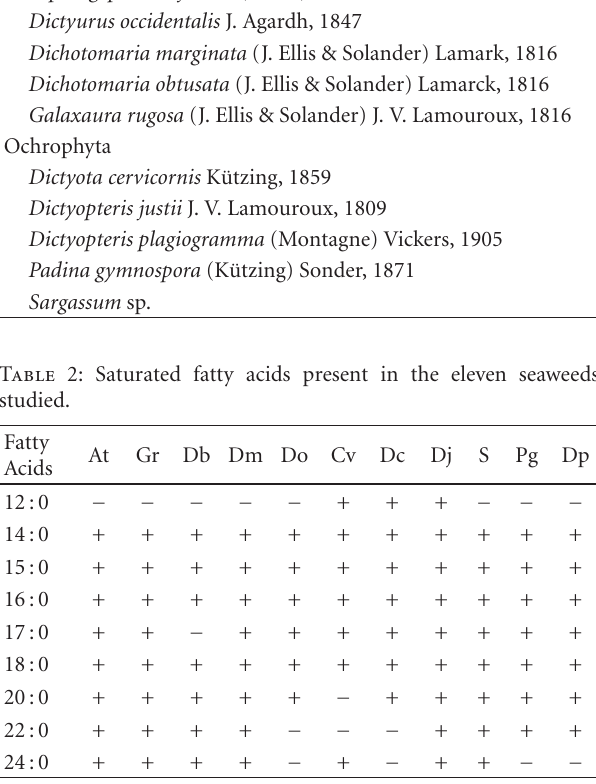
+ presence; − absence. At: Asparagopsis taxiformis ; Gr: Galaxaura rugosa ; Db: Dichotomaria obtusata ; Dm: Dichotomaria marginata ; Do: Dictyurus occidentalis ; Cv: Caulerpa verticillata ; Dc: Dictyota cervicornis ; Dj: Dicty- opteris justii ; S: Sargassum sp.; Pg: Padina gymnospora ; Dp: Dictyopteris plagiogramma .